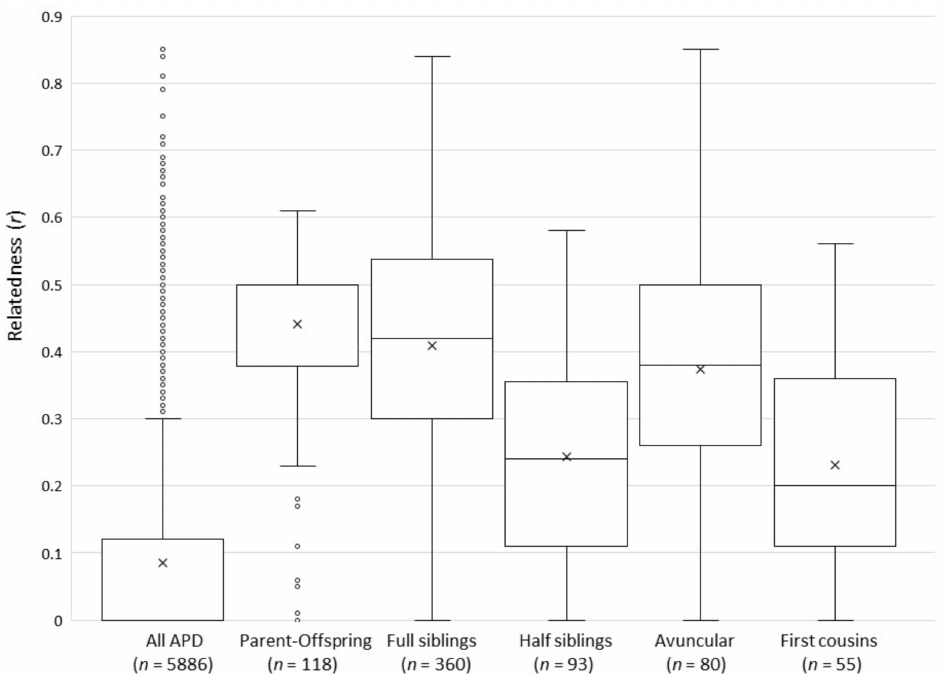
Figure 3. Box and whisker plots of pairwise relatedness coefficients ( r ) between pairs of APD, including the entire NA sample and five categories of relationships as defined by studbook records. Mean relatedness is indicated by an X within each box; median is indicated by a horizontal line within each box; outliers are shown by open circles above or below whiskers. The numbers of pairwise comparisons conducted within each defined relationship category are indicated in parentheses ( n